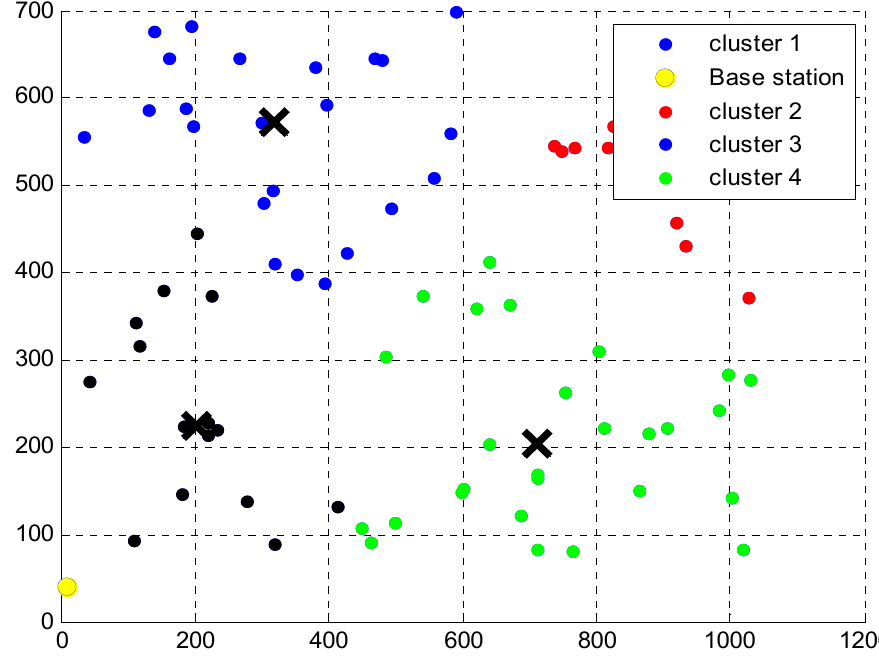
Figure 2. Simulation node setup vs. cluster formation.